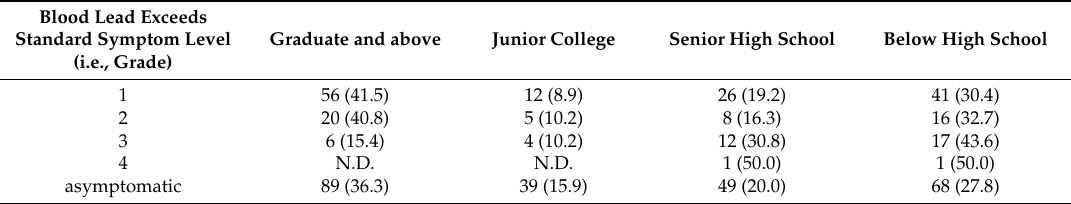
Table 8. The relationship between educational level of parents and